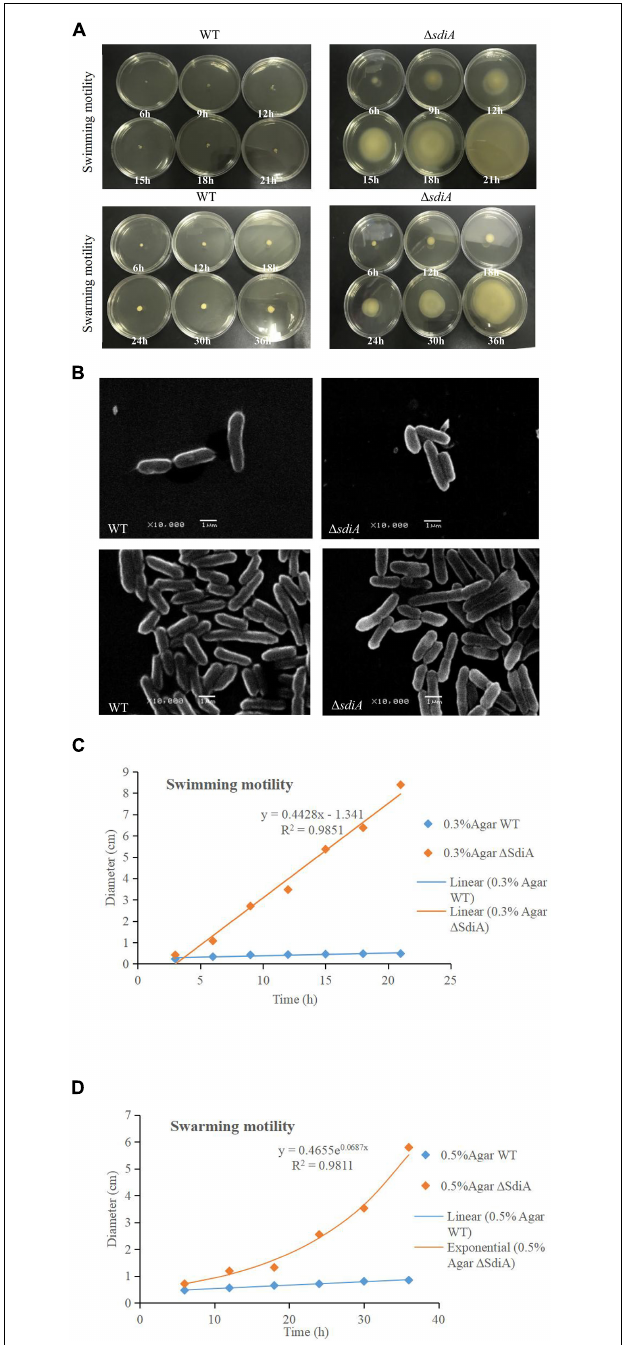
FIGURE 3 | C. sakazakii WT and (cid:49) sdiA mutant strains cell viability and morphology differences. (A) WT and (cid:49) sdiA mutant strains motility assay. (B) WT and (cid:49) sdiA mutant strains scanning electron microscopy (SEM) images. (C,D) WT and (cid:49) sdiA mutant strains motility assay curve.